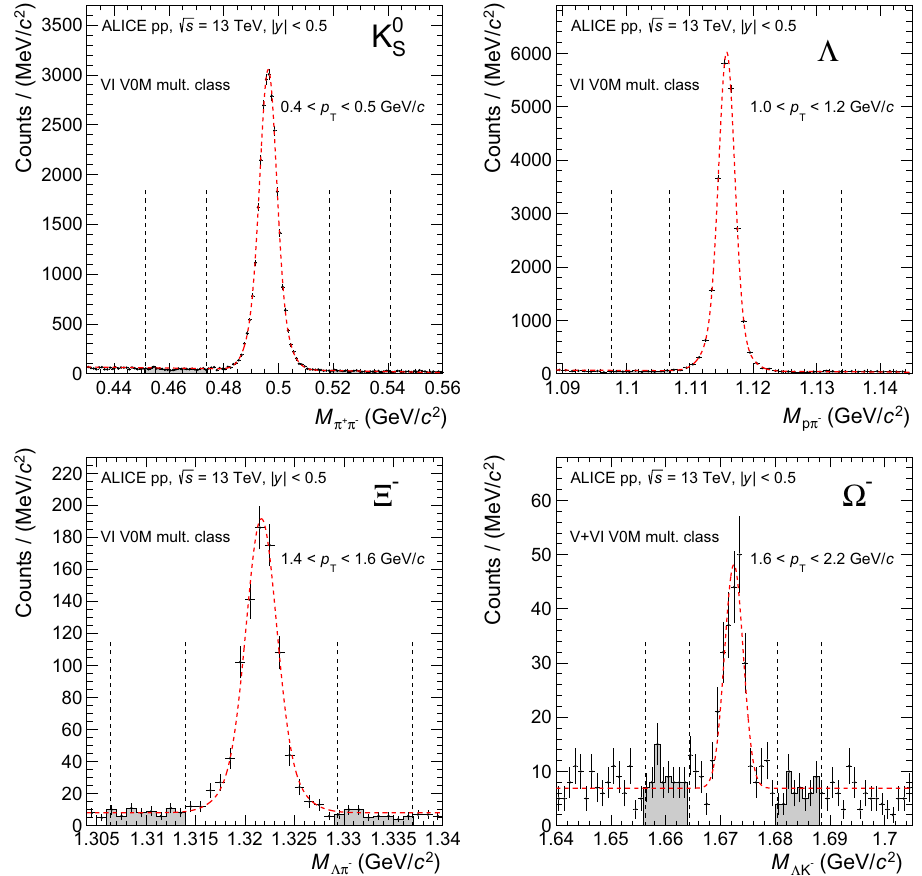
Fig. 1 Invariant mass distributions for K 0 , (cid:3) , (cid:4) − , (cid:5) − S in different V0M multiplicity and p T intervals. The candidates are reconstructed in | y | < 0 . 5. The grey areas delimited by the short-dashed lines are used for signal extraction in the bin counting procedure. The red dashed lines represent the fit to the invariant mass distributions, shown for drawing purpose